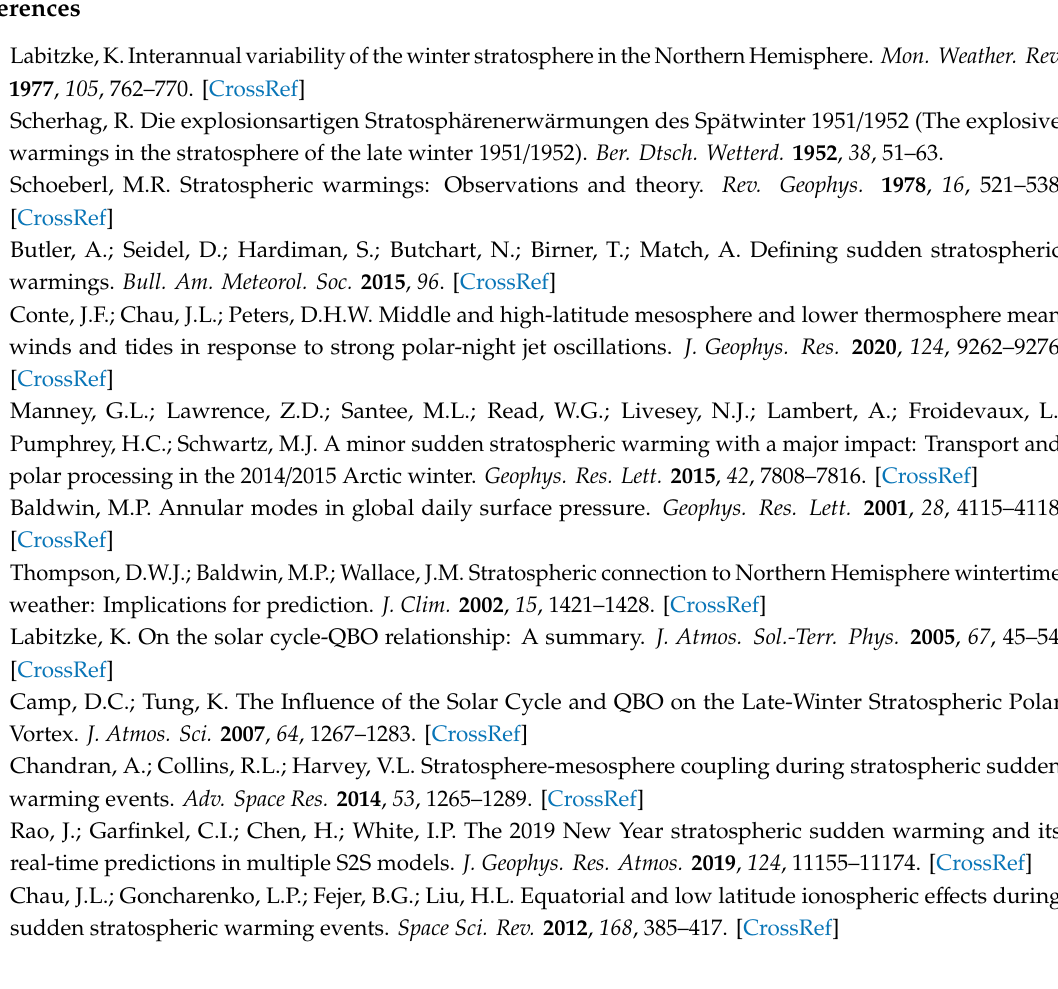
Figure S1: Polar temperature at 90 ◦ S for 1 and 10 hPa (upper panels) and zonal mean of zonal wind at 60 ◦ S (bottom panels) for 1 and 10 hPa during 1 August 2015–30 October 2015, Figure S2: Polar temperature at 90 ◦ N for 1 and 10 hPa (upper panels) and zonal mean of zonal wind at 60 ◦ N (bottom panels) for 1 and 10 hPa during 1 January 2014–31 March 2014, Figure S3: Polar temperature at 90 ◦ N for 1 and 10 hPa (upper panels) and zonal mean of zonal wind at 60 ◦ N (bottom panels) for 1 and 10 hPa during 1 January 2020–31 March 2020, Figure S4: Zonal mean of temperature (upper panels) and zonal wind (bottom panels) for 7, 10, and 30 hPa during period 1 August 2015–30 October 2015, Figure S5: Zonal mean of temperature (upper panels) and zonal wind (bottom panels) for 7, 10, and 30 hPa during period 1 January 2014–31 March 2014, Figure S6: Zonal mean of temperature (upper panels) and zonal wind (bottom panels) for 7, 10, and 30 hPa during period 1 January 2020–31 March